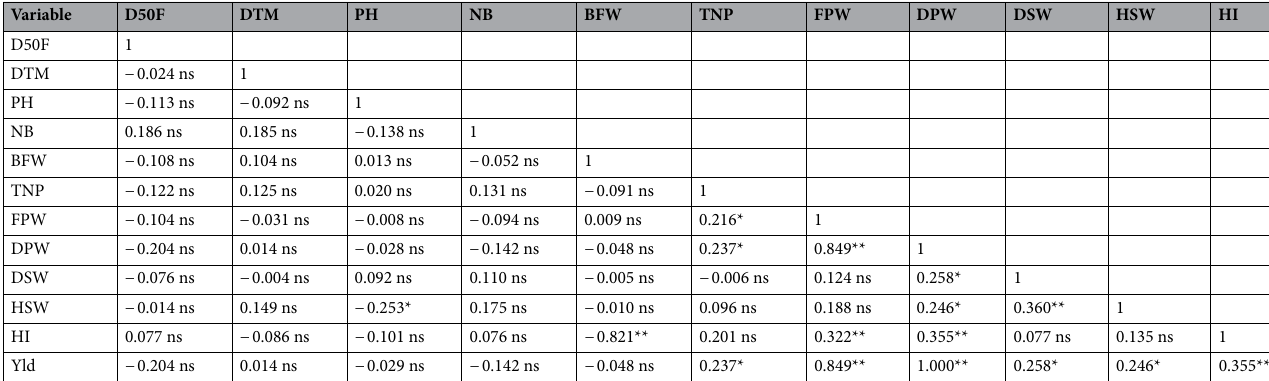
Table 7. Estimation of environmental correlation among 12 characters of V. subterranea genotypes. * = Significant (p ≤ 0.05),** = Highly significant (p ≤ 0.01), ns = non significant (p > 0.05), D50%F = days to